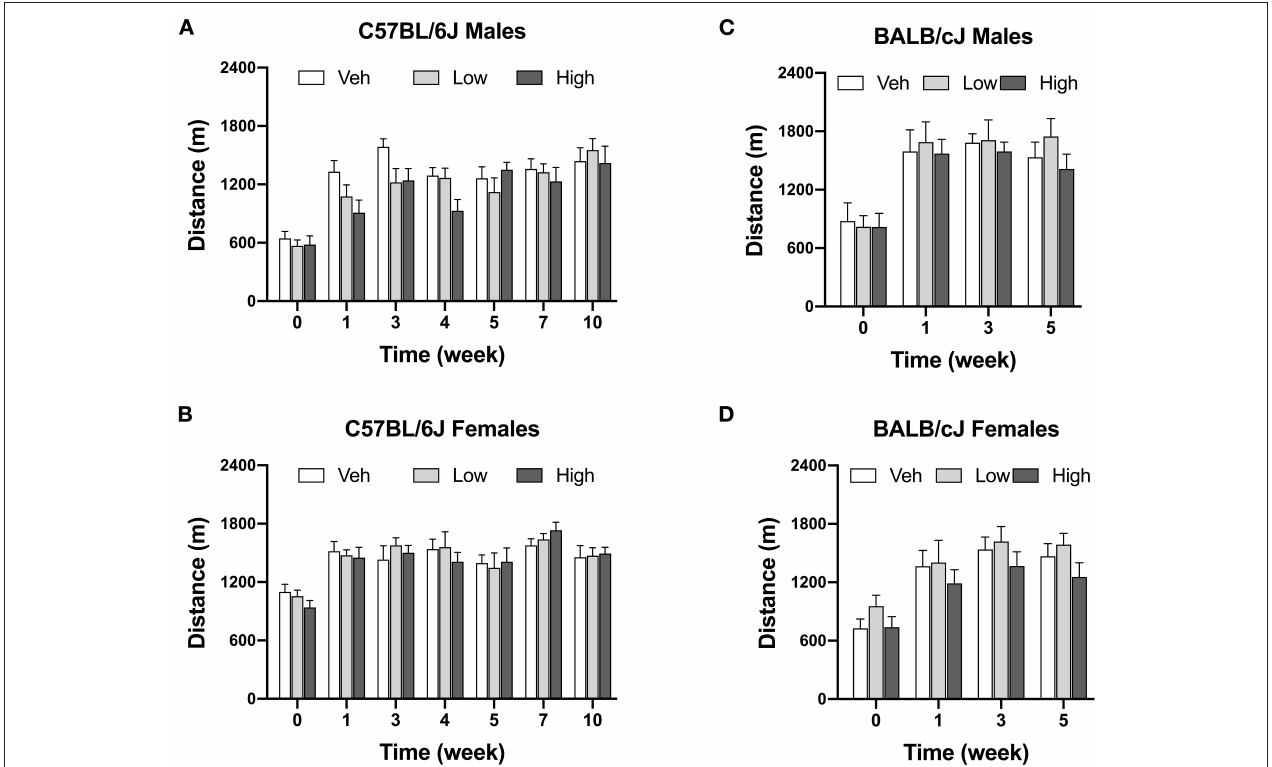
FIGURE 5 | Oxaliplatin has no effect on voluntary wheel running in mice. C57BL/6J males ( n = 8–10/group) (A) , C57BL/6J females ( n = 6–8/group) (B) , BALB/cJ males ( n = 7–9/group) (C) , BALB/cJ females ( n = 10/group) (D) . Values are expressed as mean ± SEM. Results were analyzed using two-way or mixed-analysis model ANOVA (Treatment, Time as RM) for each strain and for each sex followed by Tukey’s post-hoc test, p <